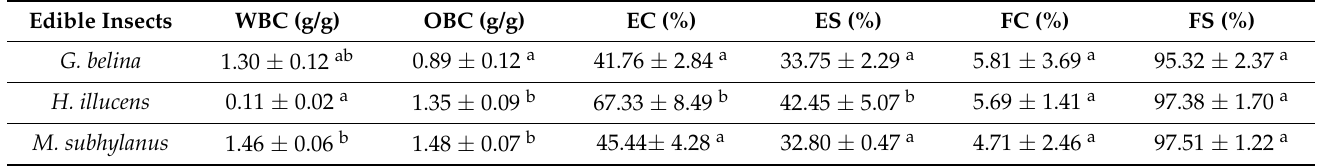
Table 3. Techno-functional properties of three edible insect